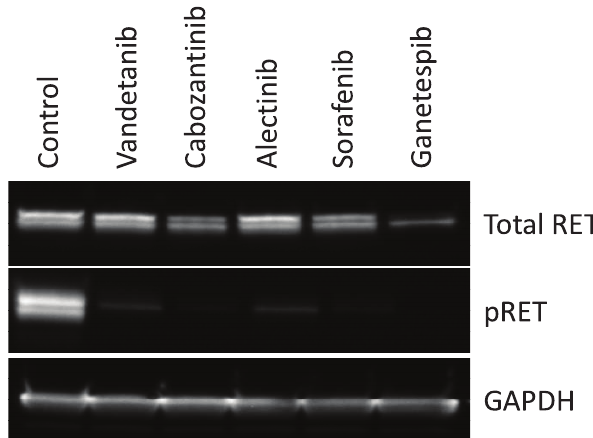
Figure 3. Degradation of RET protein following treatment with ganetespib. Western blot showing effects of compound treatment (1µM, 24 hours) on pRET, total RET and GAPDH levels in MZ-CRC-1